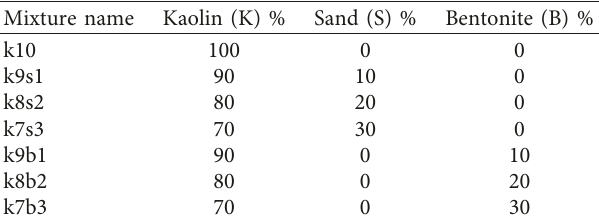
Table 1: Kaolin-dominated mixture (by weight).